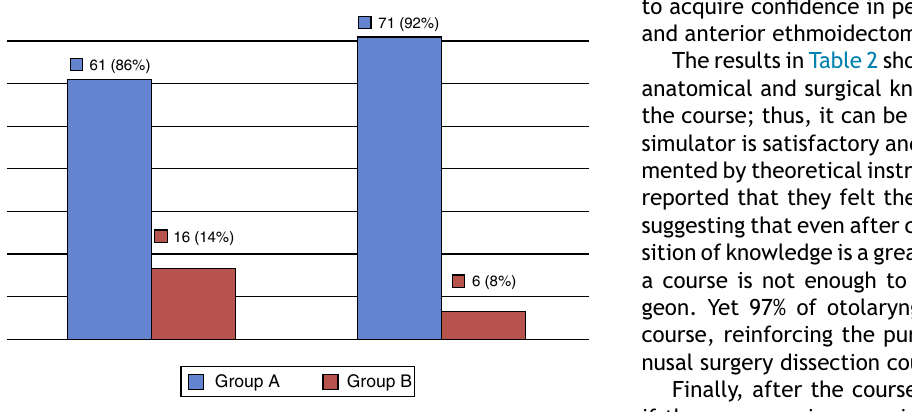
Figure 5 Number of surgeons before and after